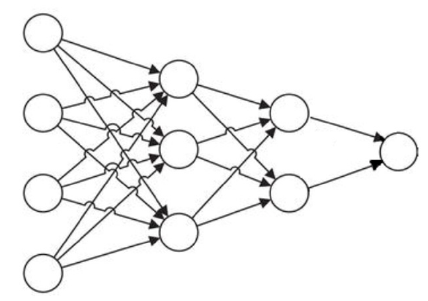
Figure 3. The scheme of a GRNN.